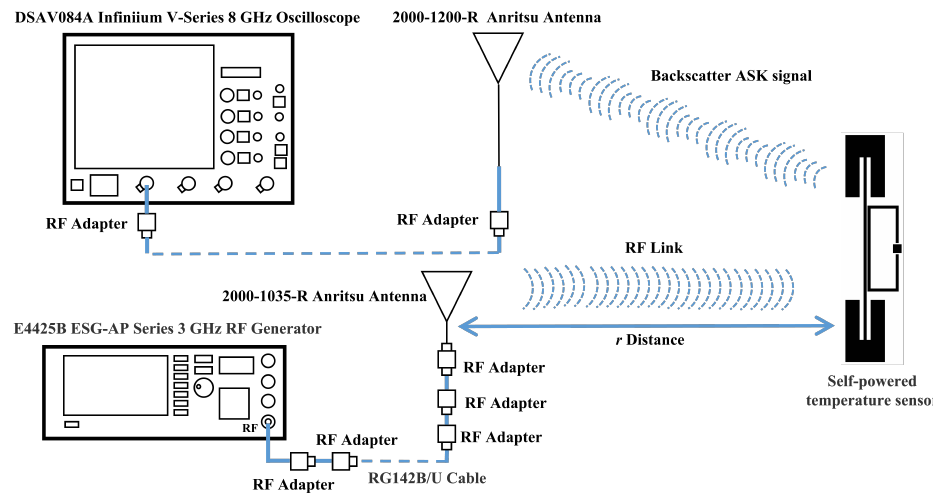
Figure 31. Testbench used for read range and temperature